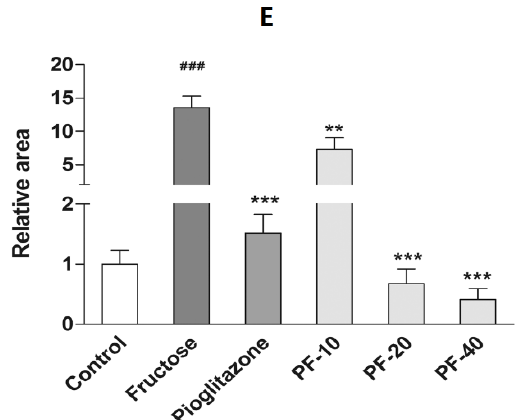
Figure 3. Effects of paeoniflorin on the hepatic lipids and glycogen contents. ( A ) Hepatic lipids contents. ( B ) Hepatic glycogen contents. ( C ) HE staining (200 × ). ( D ) Oil-red O staining (200 × ). Insets from the images are magnified five times in order to highlight the lipid-staining morphology. ( E ) Relative area of Oil-red O staining. Data were expressed as the mean ± SEM. ( n = 8). Data was analyzed by one-way ANOVA followed by Dunnett’s post hoc test. ## p < 0.01 and ### p < 0.001 vs. control group. * p < 0.05, ** p < 0.01 and *** p < 0.001 vs. fructose group. PF-10: 10 mg/kg of paeoniflorin; PF-20: 20 mg/kg